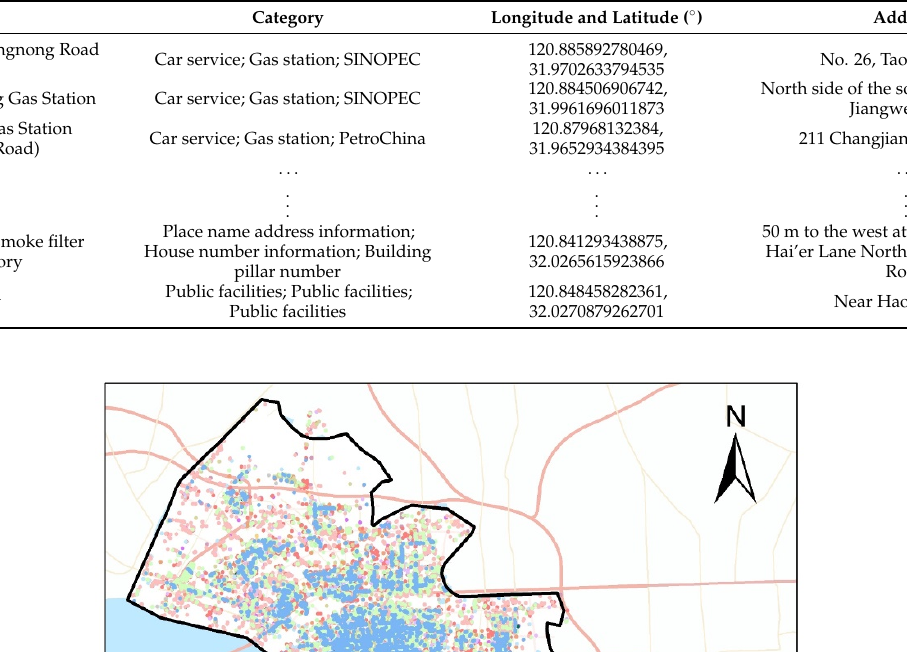
Table A1. Samples of the POI data derived from the web crawler.